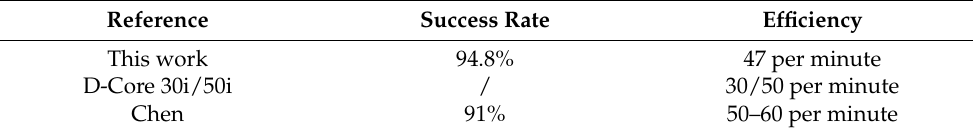
Table 2. Comparison of block-cutting efficiency and success rate of different